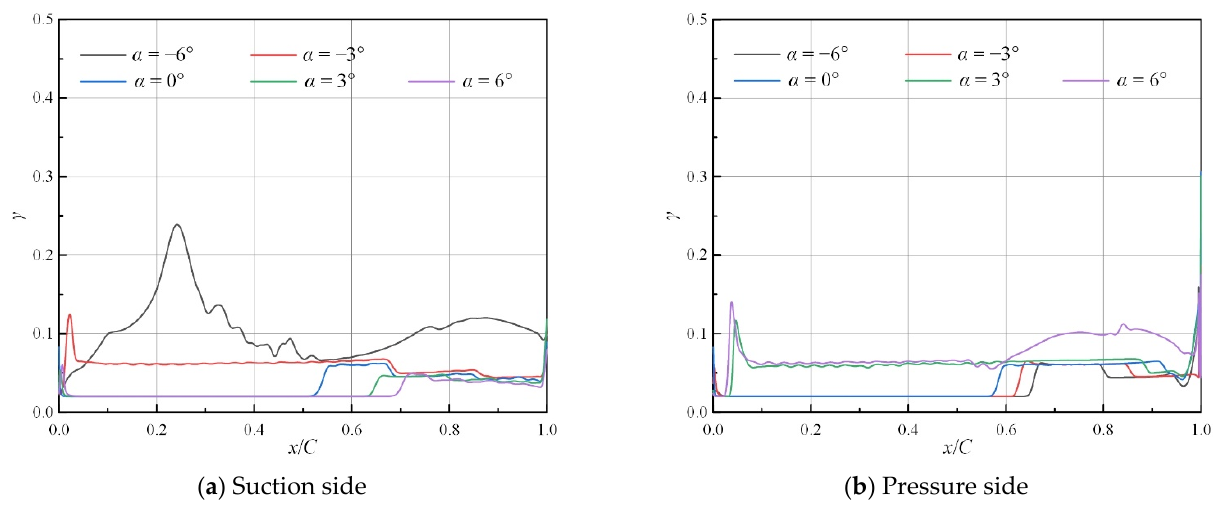
Figure 16. Distribution of intermittency along streamwise direction under various angles of attack ( ε = 0.5%, Ma = 0.4, T w = 293 K).